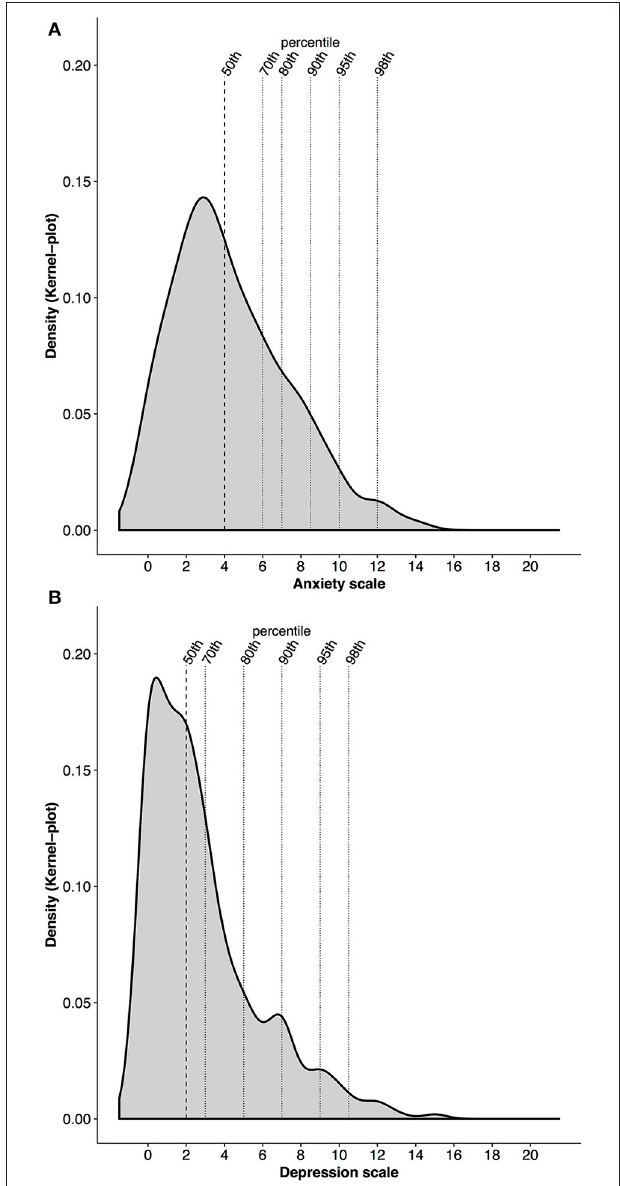
FIGURE 2 | (A,B) Density of the distribution of anxiety (A) and depression (B) with percentiles (50th, 70th, 80th, 90th, 95th, and 98th) in alignment with the HAD Scale scores.